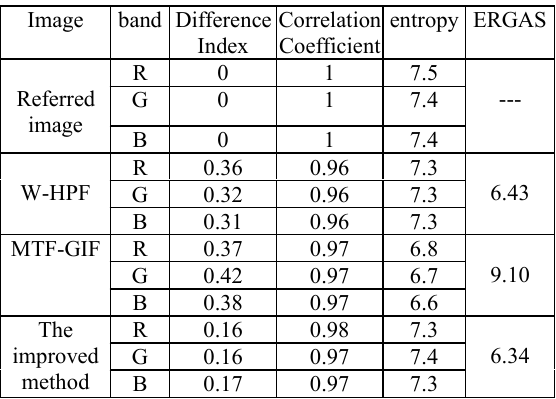
Table 1.Comparison of three fusion methods in degrade